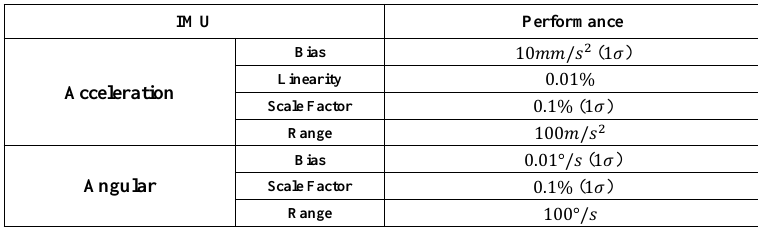
Table 1. Specification of IMU sensor. An IMU was used inside the GNSS/INS (RT3002) to estimate the pose of the LiDAR